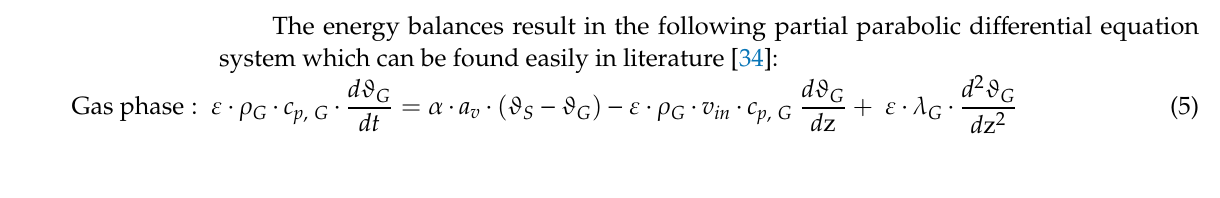
Figure 2. z and r coordinates, empty tube gas velocity v a and internal gas velocity v in and rotor length l (transverse Figure 2. (cid:1878) and (cid:1870) coordinates, empty tube gas velocity (cid:1874) (cid:3028) and internal gas velocity (cid:1874) (cid:3036)(cid:3041) and rotor length (cid:1864) (transverse view).